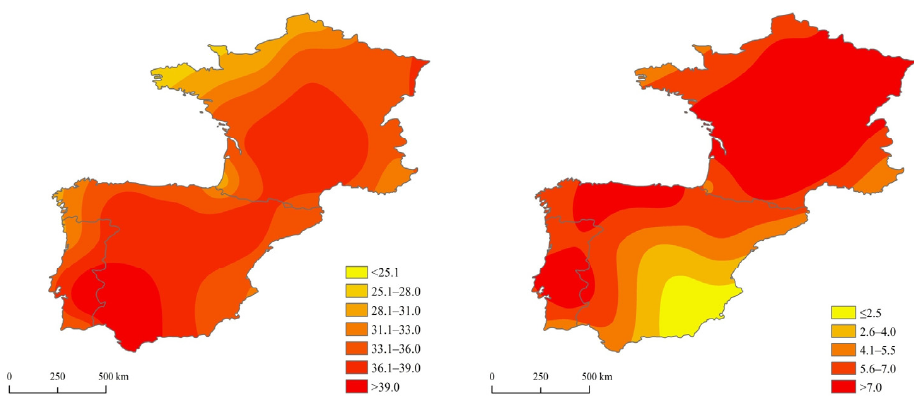
Figure 9. The mean Tmax and Tmax anomalies during the HW of 29 July–14 August 2003. Atmosphere 2017 , 8 , 31 11 of 17